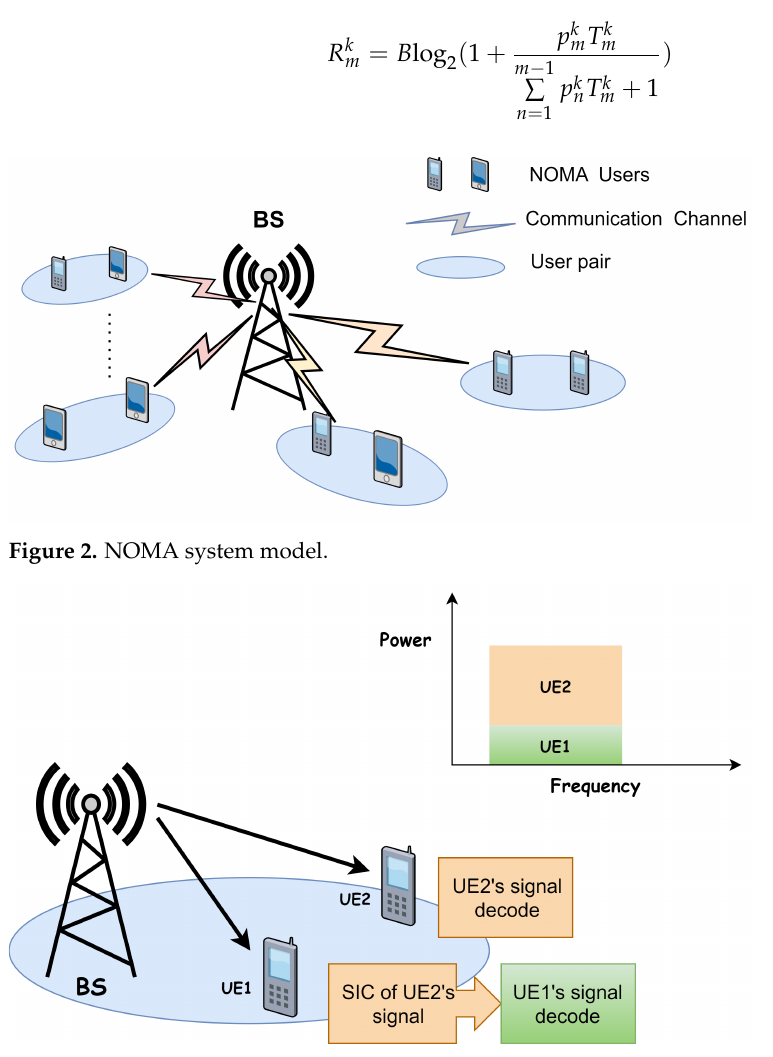
Figure 3. SIC for two